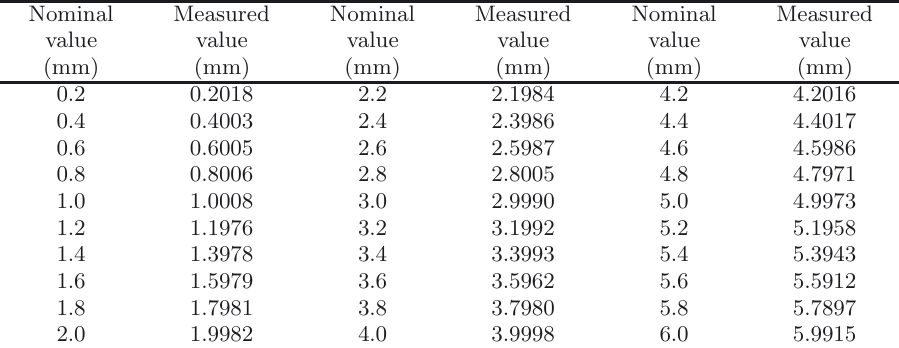
Table 1. Results obtained for the lengths of the 6 mm scale.